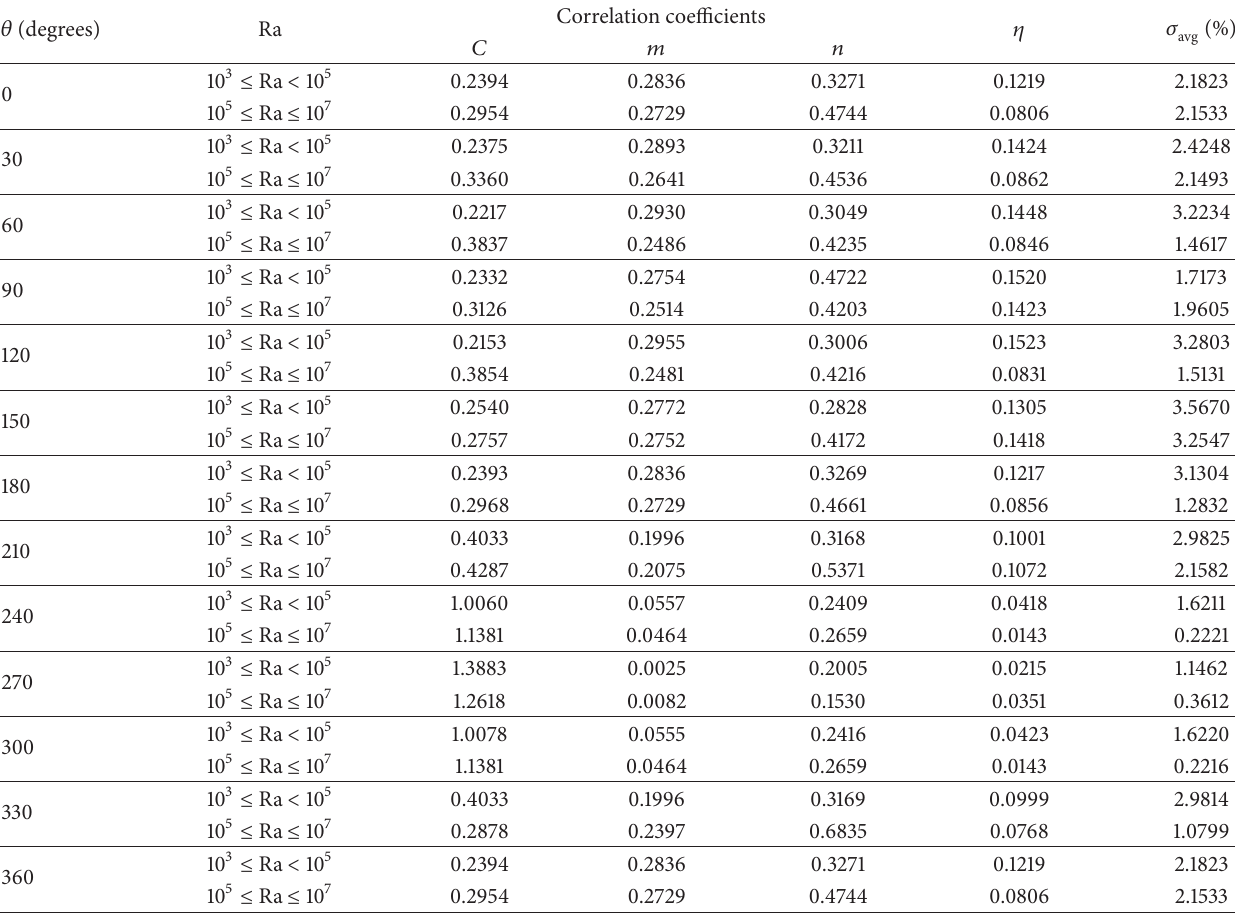
Table 1: Correlation coefficients with maximum relative error and average standard deviation in